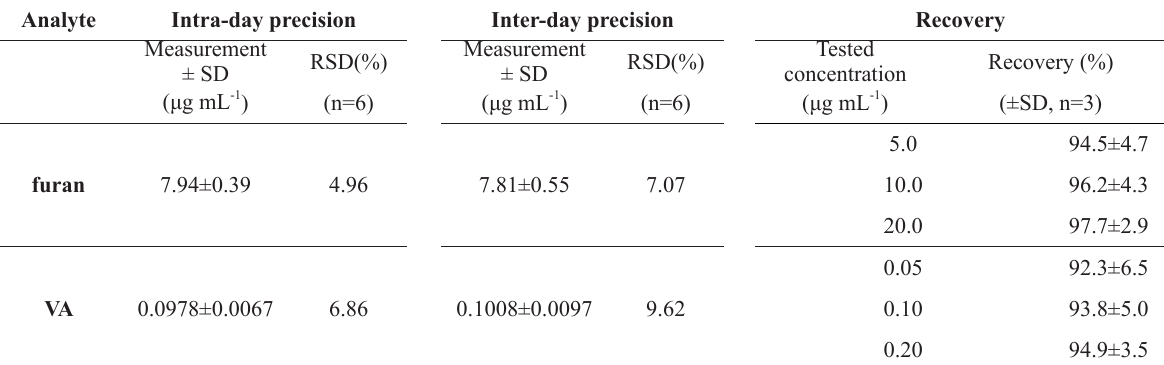
Intra-day, inter-day precision, and recovery of furan and